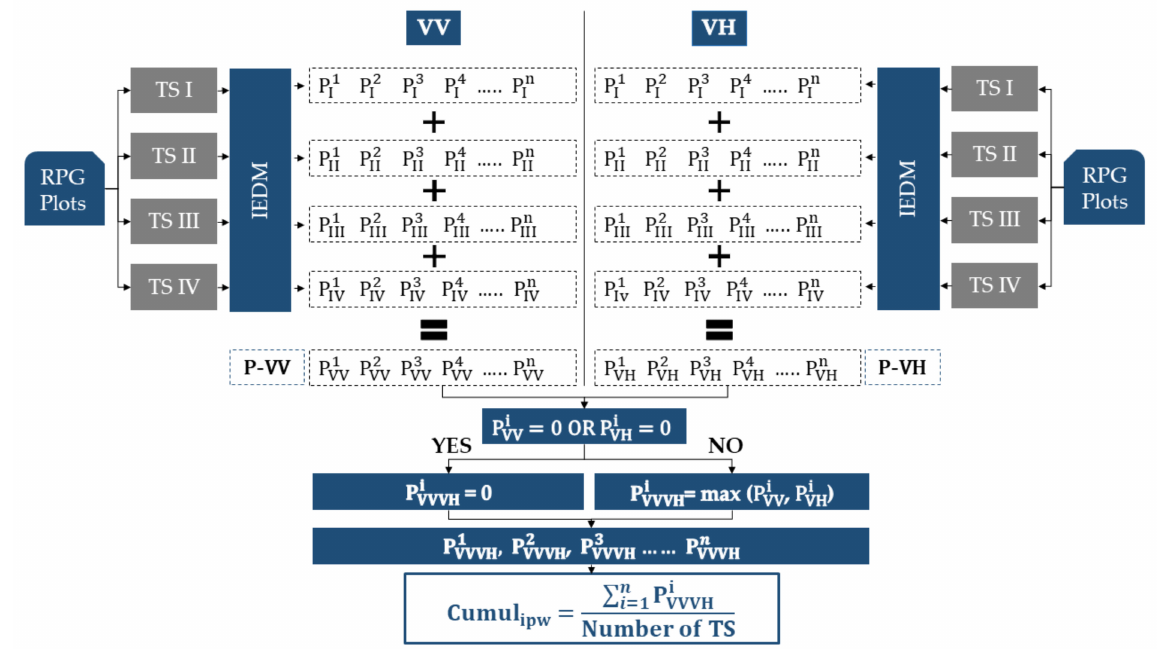
Figure 4. Detailed description of the combination of temporal series (TS) in VV and VH polarizations to calculate the irrigation metric for each plot using the IEDM. n is the number of images (dates) in each TS and i represents the date. Number of TS equals to 4 in our